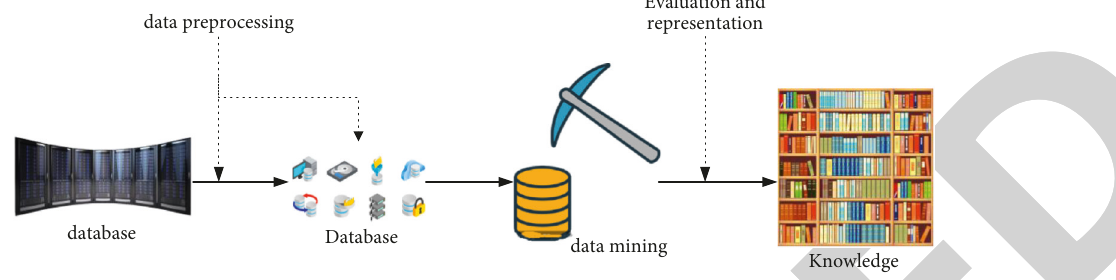
Figure 6: Data mining flowchart.